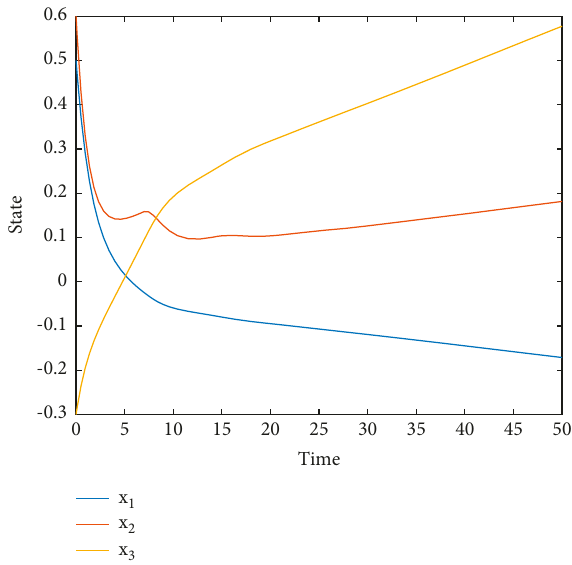
Figure 6: The state of (43) without impulse.